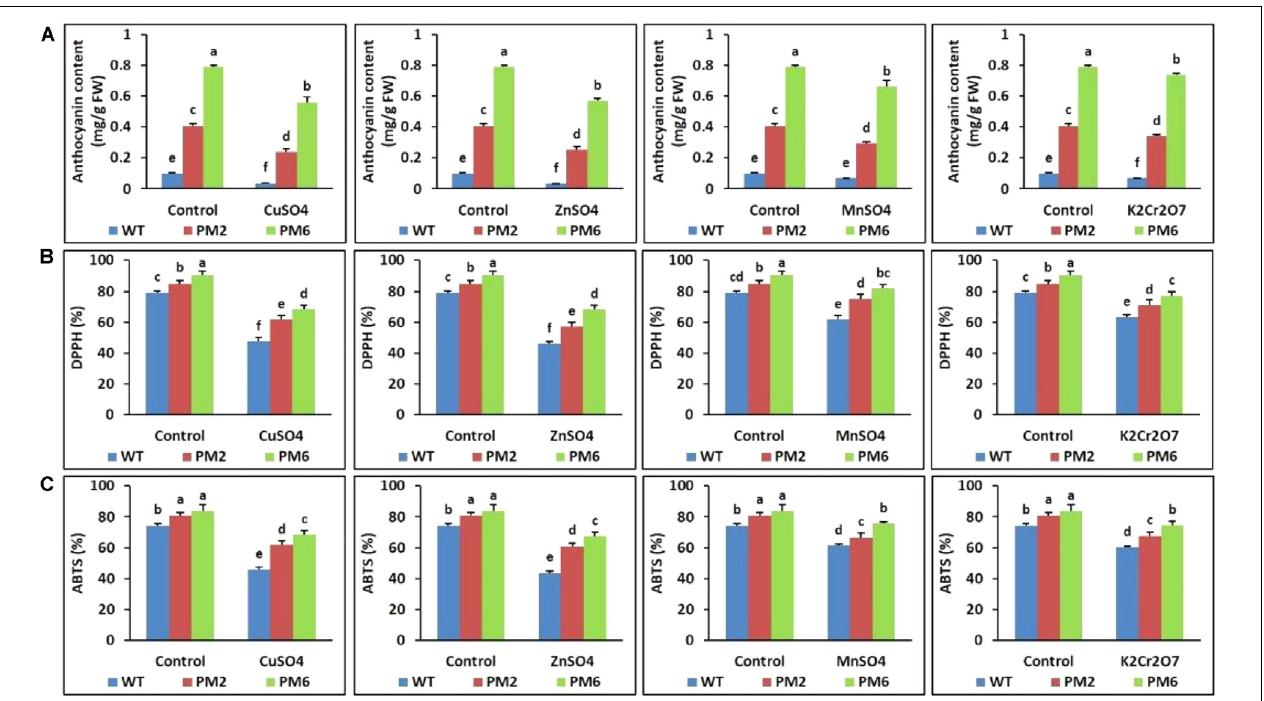
FIGURE 6 | Comparison of anthocyanin content (A) and ROS-scavenging activities assessed by DPPH (B) and ABTS (C) assays in the T 2 -PM6, T 2 -PM2, and WT plants after exposure to the indicated heavy metals. Data were collected on the thirtieth day after starting the experiments. Error bars show the